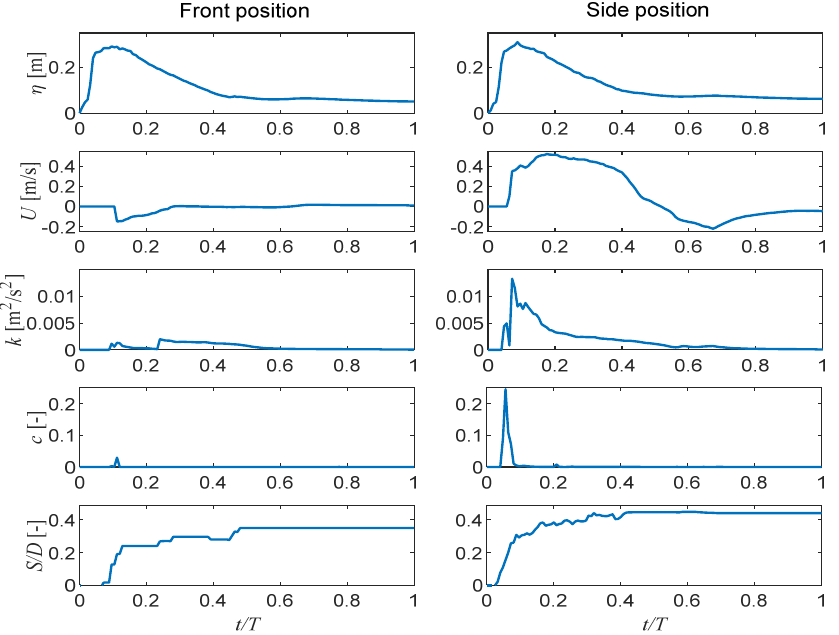
Figure 13. Comprehensive comparison of different variables development at the front and side positions of the structure.